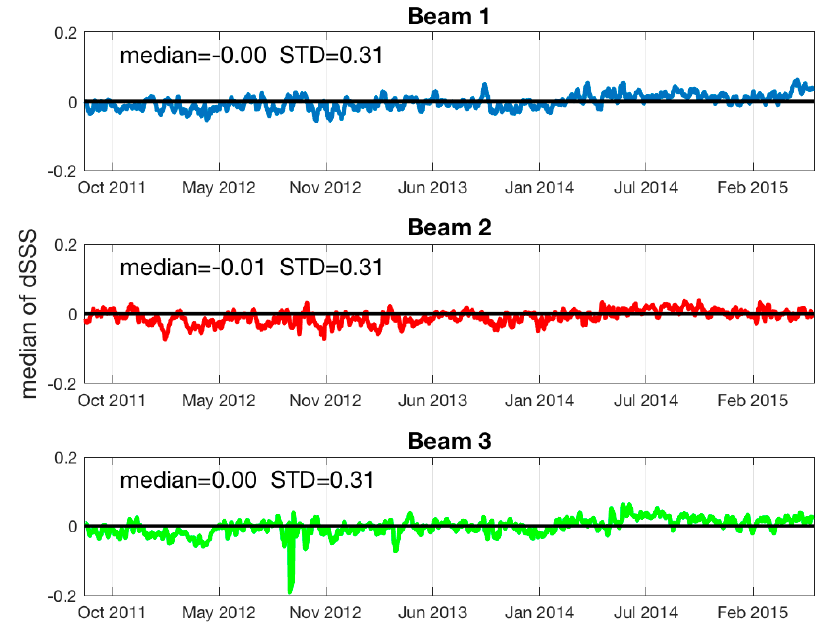
Figure 2. Time series of daily median of global Aquarius—in situ SSS in three beams. 7-day average is applied to smooth the data. The median and the standard deviation (STD) labeled in the figures are based on the average of differences for the whole mission period from September 2011 to May 2015.